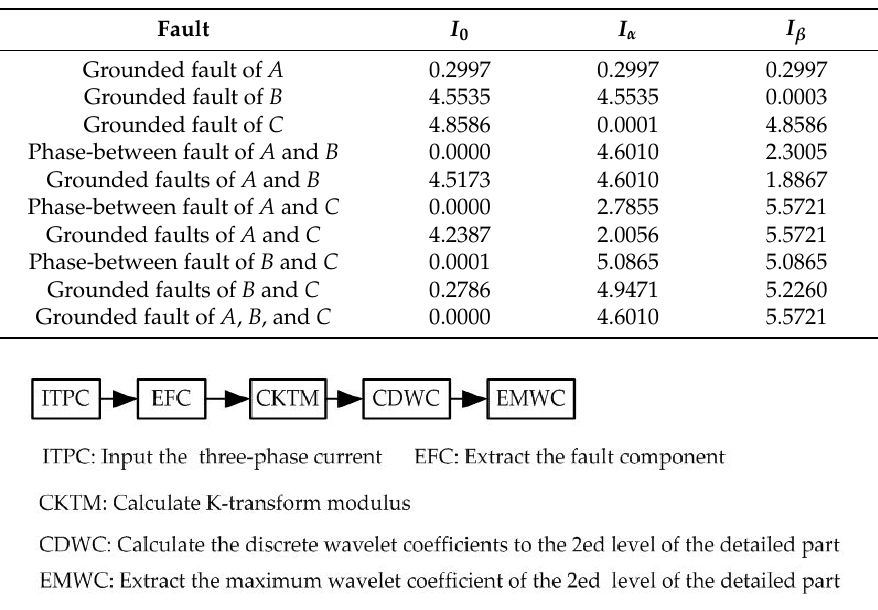
Figure 4. Flow chart of the calculation of the maximum wavelet coefficients.